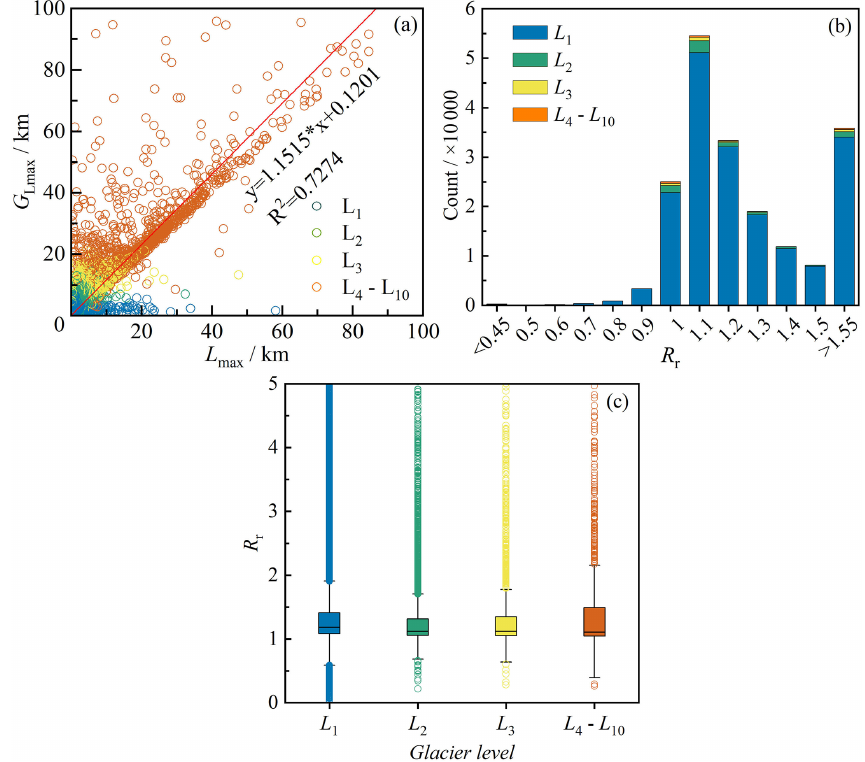
Figure 6. Comparison between longest centerlines calculated in this study and by Machguth and Huss (2014). (a) Linear regression of maximum length for all input glaciers (IGODS), determined as G Lmax , calculated in this study, and L max , obtained in Machguth and Huss (2014). (b) Histogram of the length ratio ( R r ; G Lmax /L max ) for distinct grades of glaciers. (c) Box plots of length ratio ( R r ) for different scales of